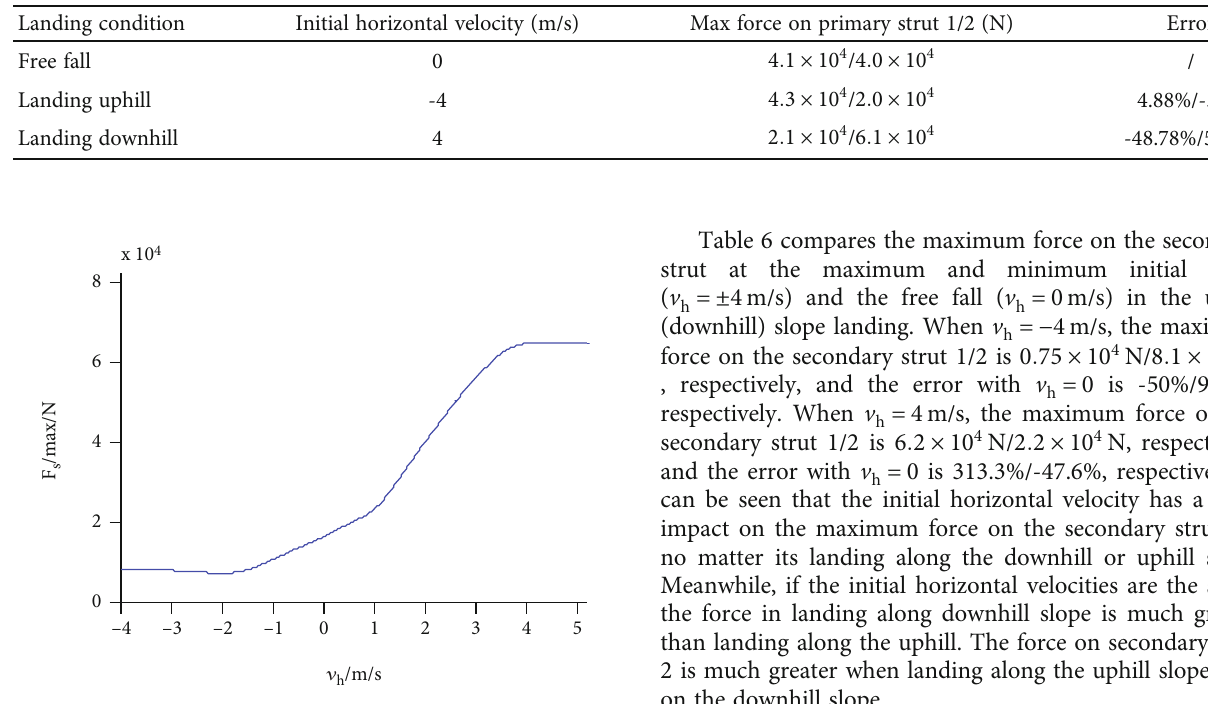
Table 5: Impact of initial horizontal velocity on the maximum force on primary